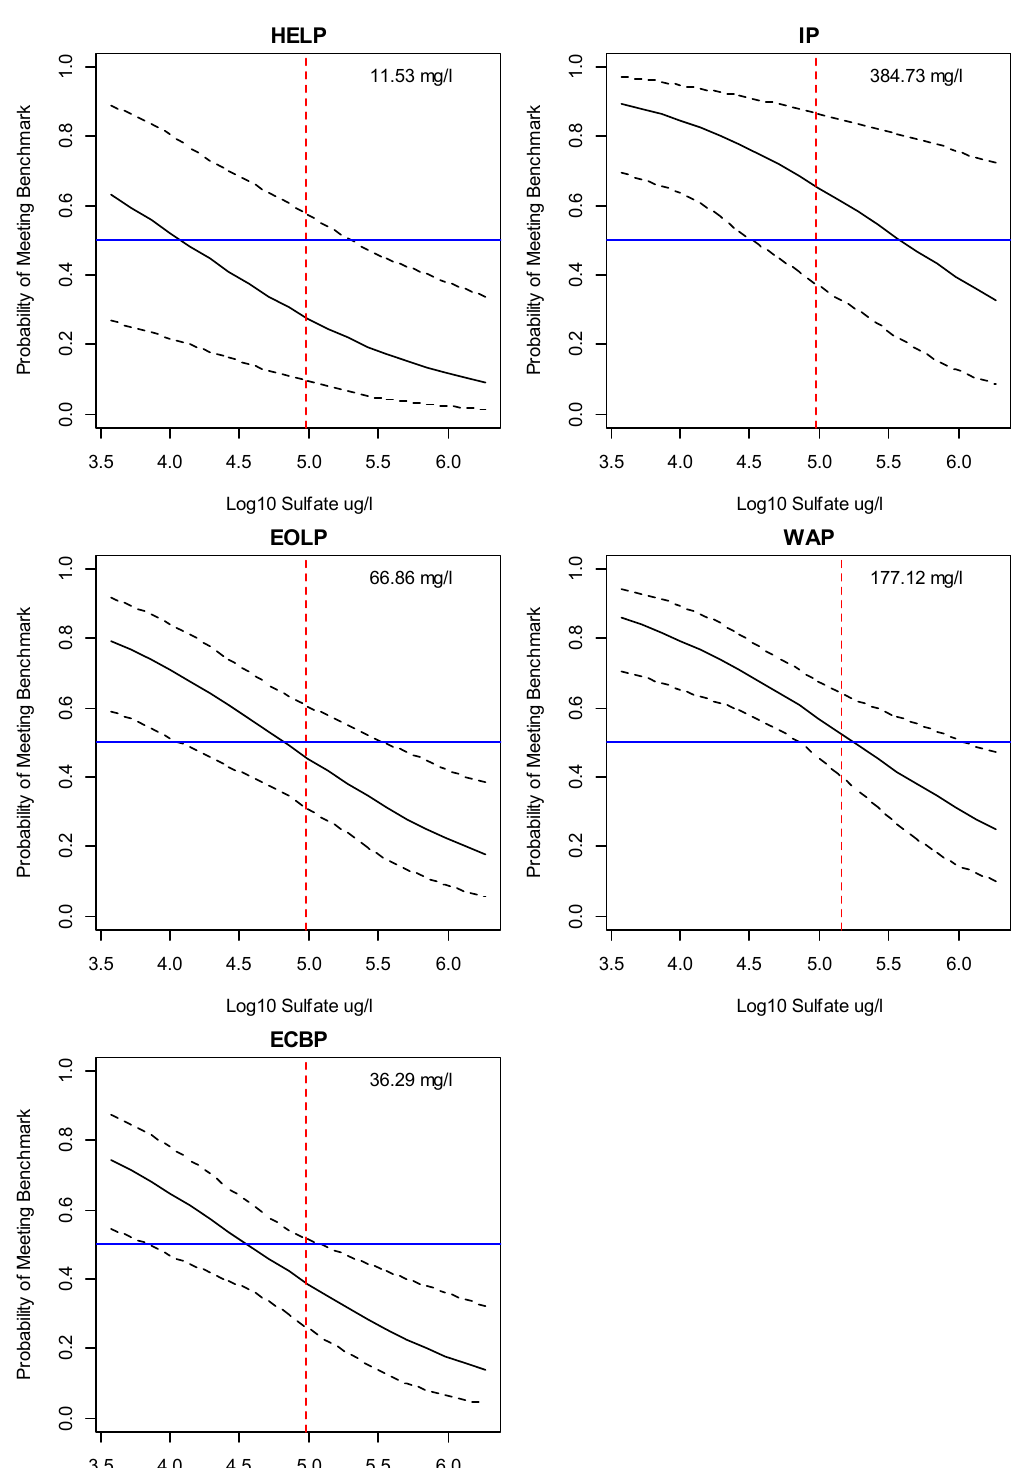
Figure 7. Predicted probabilities and 95% credible intervals of macroinvertebrate communities meeting their ecoregion benchmark as function of sulfate concentrations when other model parameters are held at their ecoregion medians. The vertical dashed red line is the HC5, equating to 90 mg/L for the four ecoregions exclusive of the WAP, and 152 mg/L for the WAP. The blue horizontal line is drawn at p = 0.5 for reference. Respective median effect levels in standard units are inset as text in the upper right of each plot.